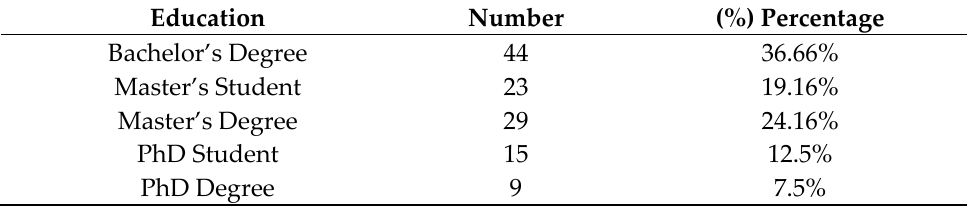
Table 5. Distribution of participants according to their level of education.